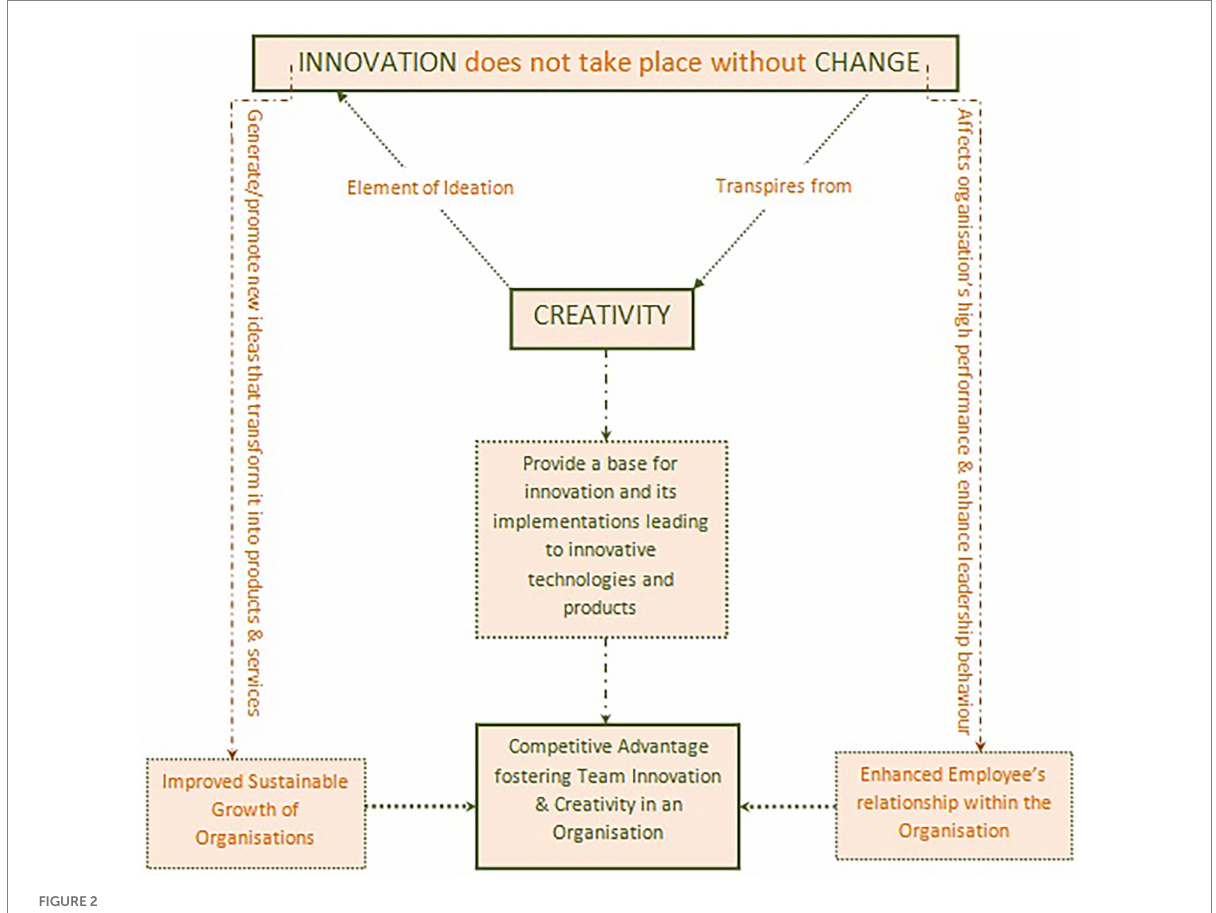
FIGURE 2 Dynamics between creativity, innovation and change in R&D